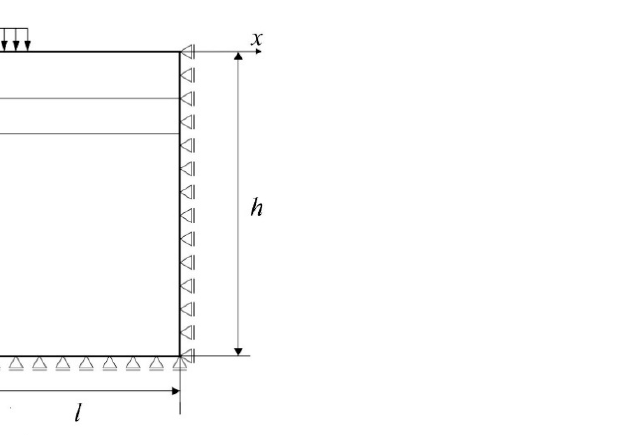
Figure 1. Section of the axisymmetric cylindrical area of a pavement modeled with the use of FEM.